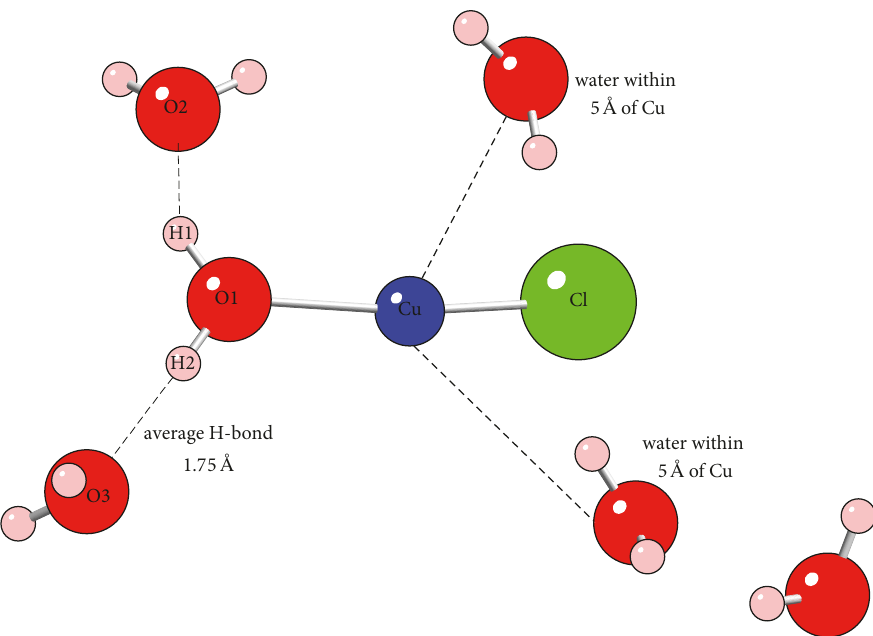
Figure 1: A snapshot of the CuCl(H 2 O) 0 complex and the surrounding